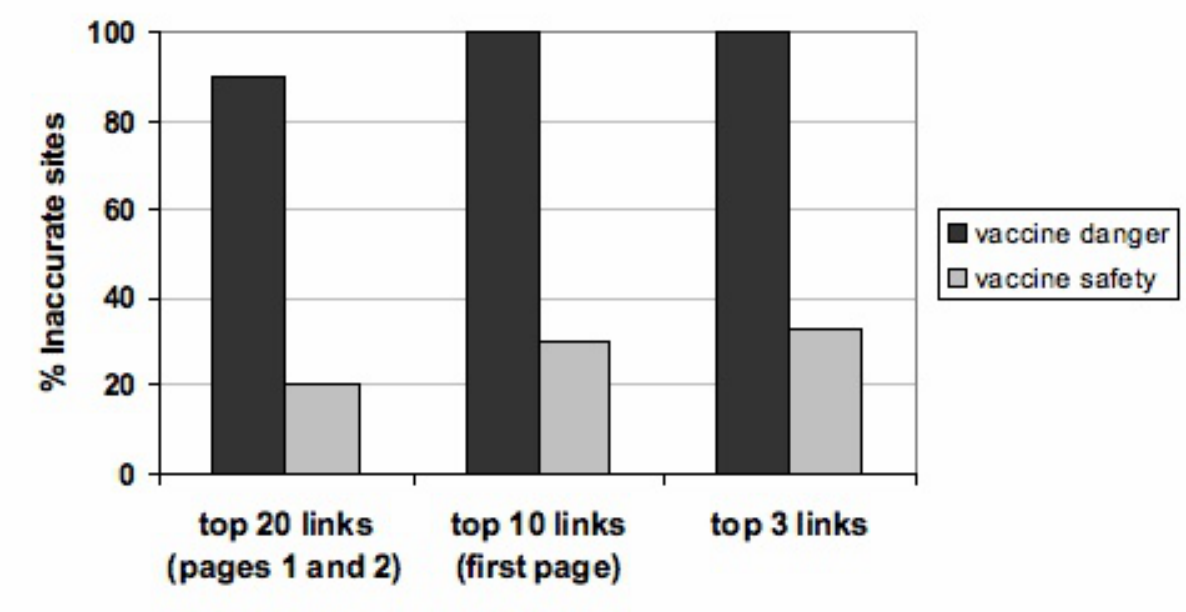
Figure 1. Percentage of inaccurate sites for three different levels of search